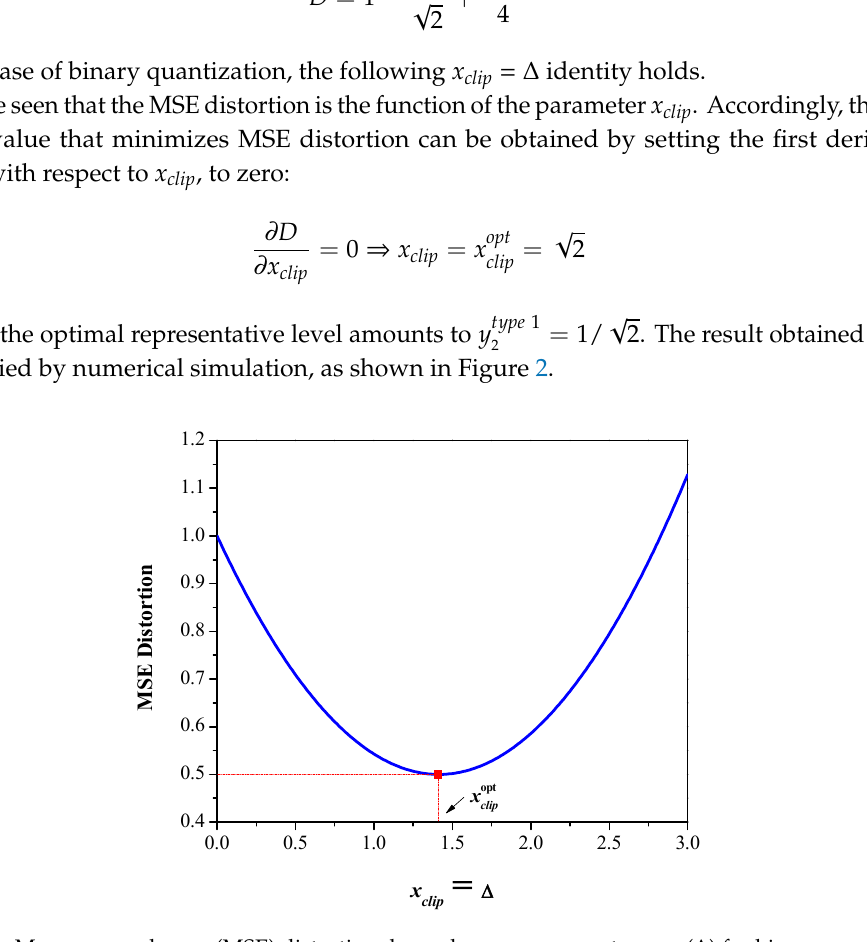
Figure 2. Mean-squared error (MSE) distortion dependence on parameter x clip ( ∆ ) for binary quantizer type 1.